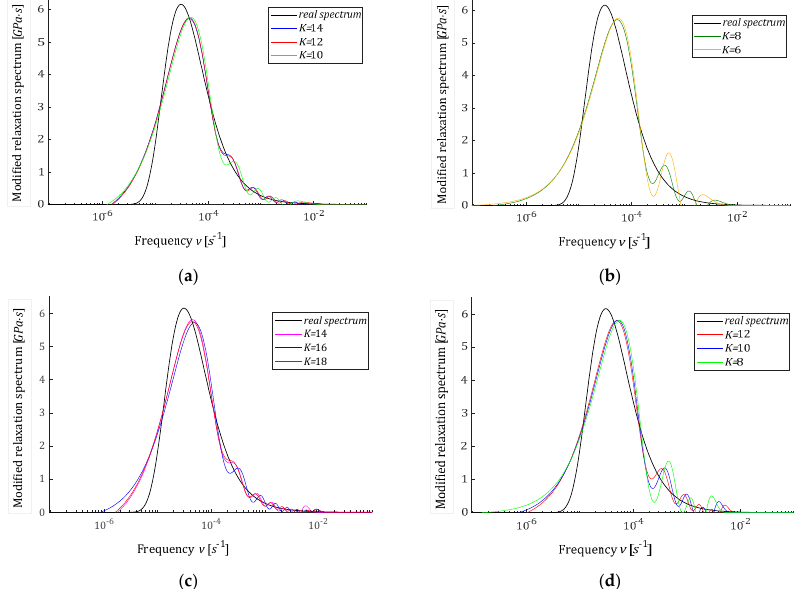
Figure 7. Modified relaxation spectrum 𝐻 (cid:3014) (𝑣) (61) (solid black line) from Example 2 and the ap- proximated models 𝐻(cid:3365) (cid:3012)(cid:3014) (𝑣) : ( a , b ) Legendre models, ( c , d ) Laguerre models.